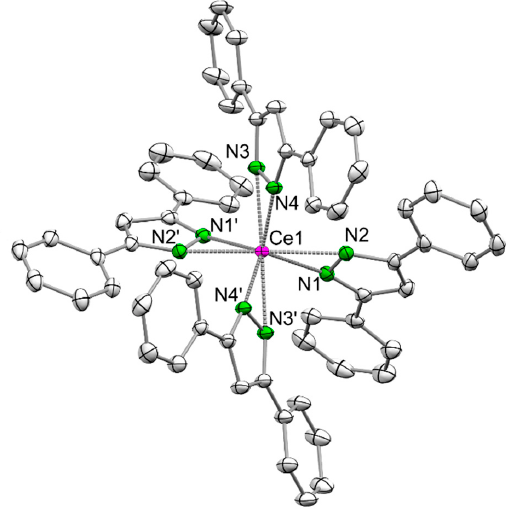
Figure 2. Crystal structure of Ce(Ph 2 pz) 4 ( 2 ). Ellipsoids are shown at the 50% probability level. Hydrogen atoms and lattice toluene are omitted for clarity. Selected interatomic distances (Å) and angles (°): Ce1 − N1 2.3790(16), Ce1 − N2 2.3381(16), Ce1 − N3 2.3409(15), Ce1 − N4 2.3575(16); N1 − Ce1 − N3 113.41(6), N1 − Ce1 − N4 118.73(5), N2 − Ce1 − N3 96.05(6), and N2 − Ce1 − N4 87.76(5).